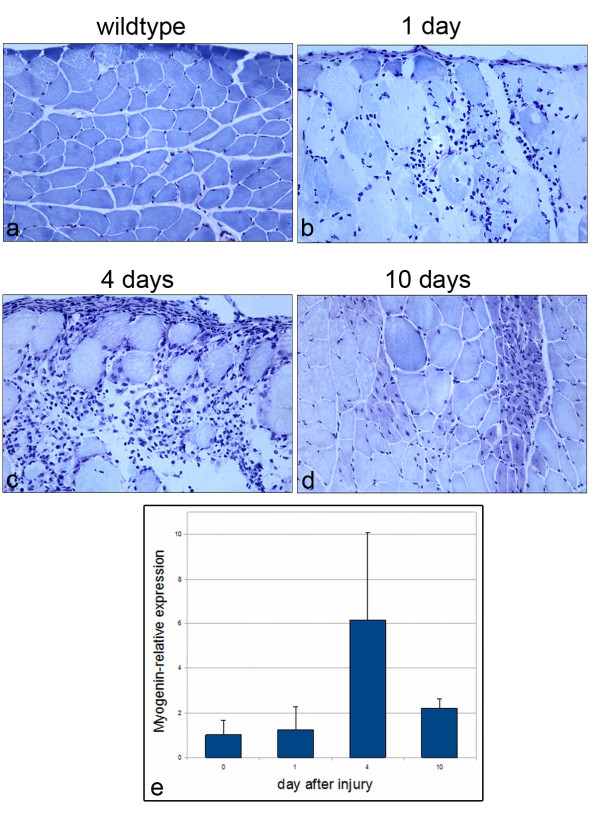
Histological analysis of muscle after injury. Sections of the gastrocnemius muscle before (A) and after trauma stained with Toluidin blue reveal invasion of mononucleated cells after 1 day (B) and massive regeneration after 4 days (C). 10 days after injury (D) regeneration is nearly completed and multiple regenerated fibers are visible. Magnification is 200×. (E) Expression analysis of Myogenin showing highest expression levels after 4 days of injury (n = 6 control animals, n = 2 animals at day 1 and n = 3 animals at day 4 and day 10, respectively).